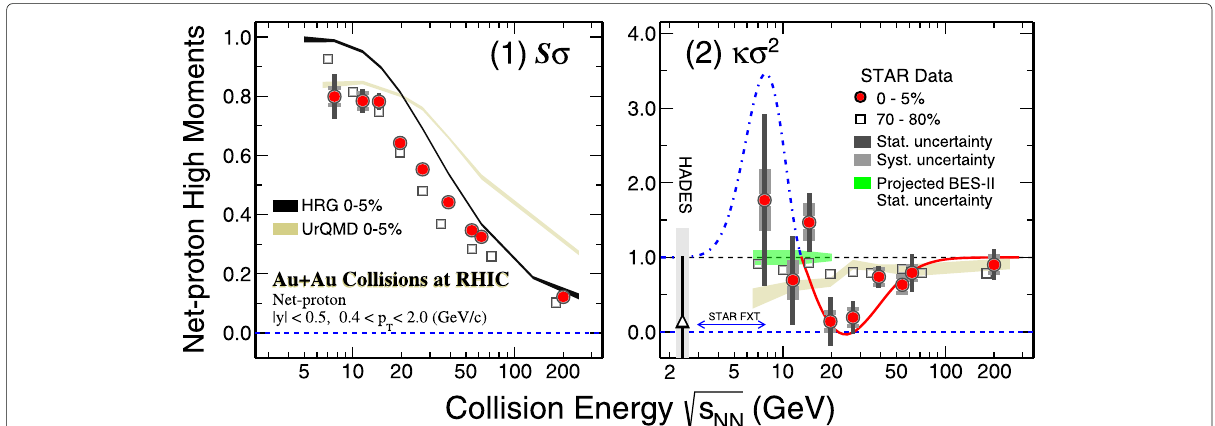
√ Fig.3 Experimental results [28] of s NN dependence of the net-proton S p σ p (left) and κ p σ 2 p (right) from 70–80% peripheral (open squares) and 0–5% central (filled circles) Au+Au collisions. In the figures the subscript, p , is omitted. Projected statistical uncertainty for the second phase of the RHIC BES program is shown by the green-band. The STAR experiments fixed-target program extends the center of the mass collision energy down to 3 GeV. Results of calculations are shown as black and gold bands for the HRG model and transport model (UrQMD), respectively. The solid red and the dashed blue line in plot (2) is a schematic representation of the expectation from a QCD-based model calculation in the presence of a critical point